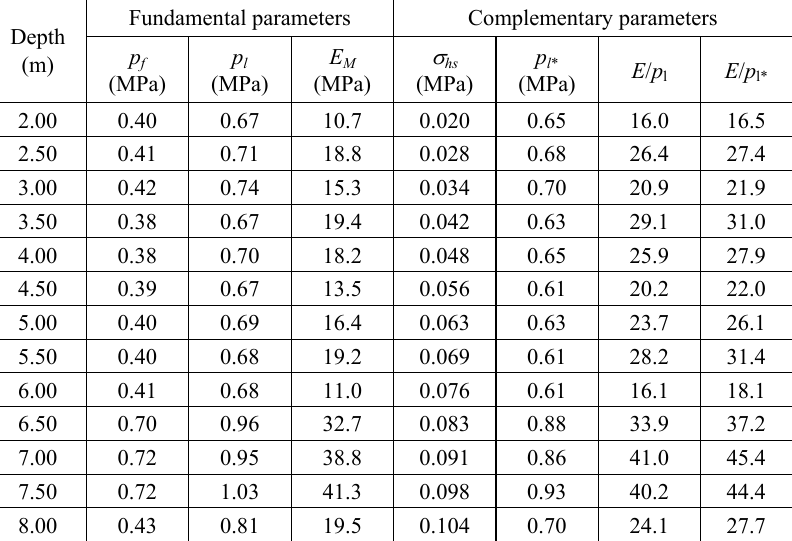
Table 1. Results of pressuremeter tests Fundamental parameters Complementary parameters Depth